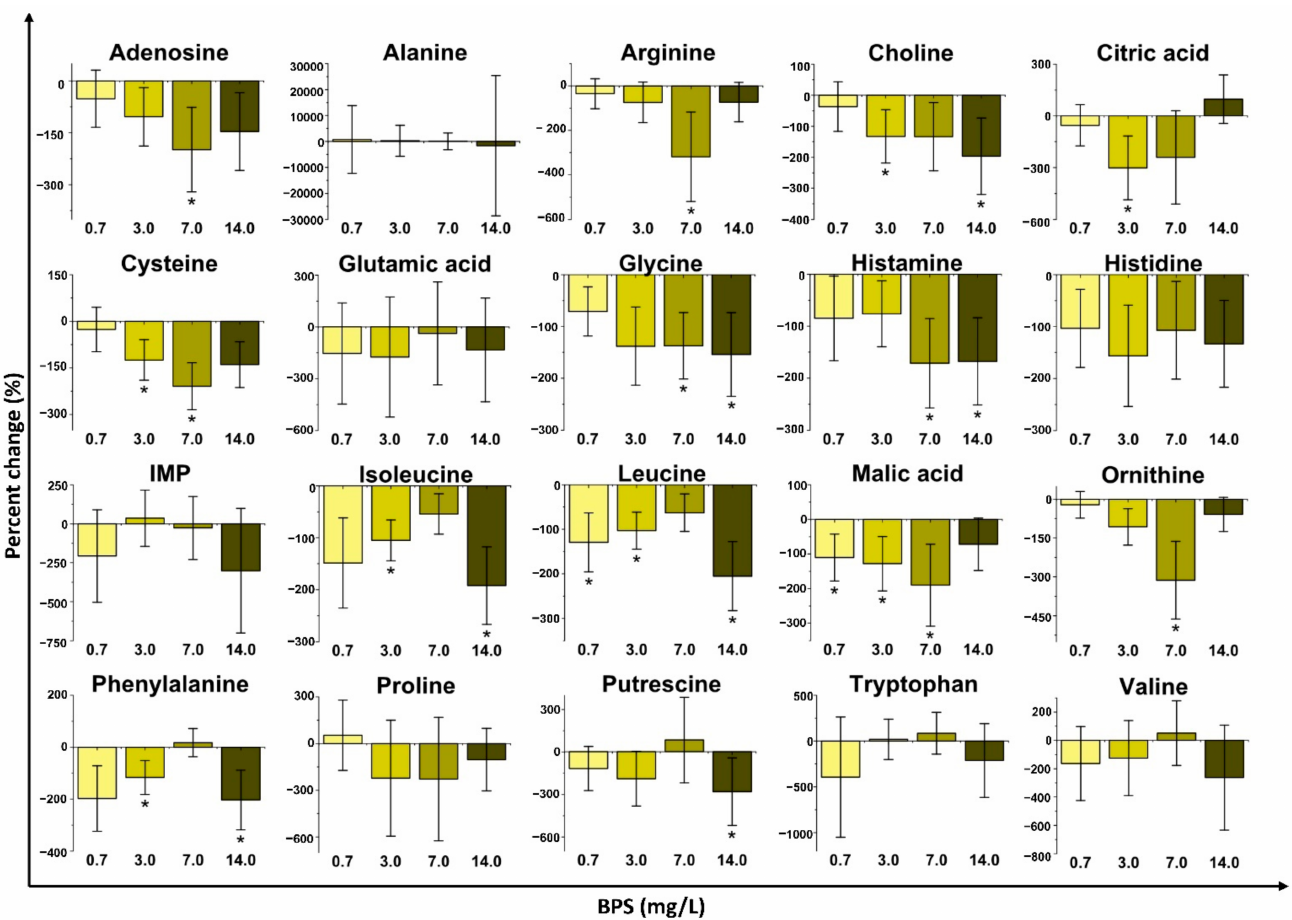
Figure 4. Metabolite percent changes of D. magna exposed to bisphenol S (BPS) at fractions of median effective concentration (EC 50 ) values. The percent changes of the contaminant exposure are relative to a control. ( n = 10 and * p ≤ 0.05). IMP = inosine